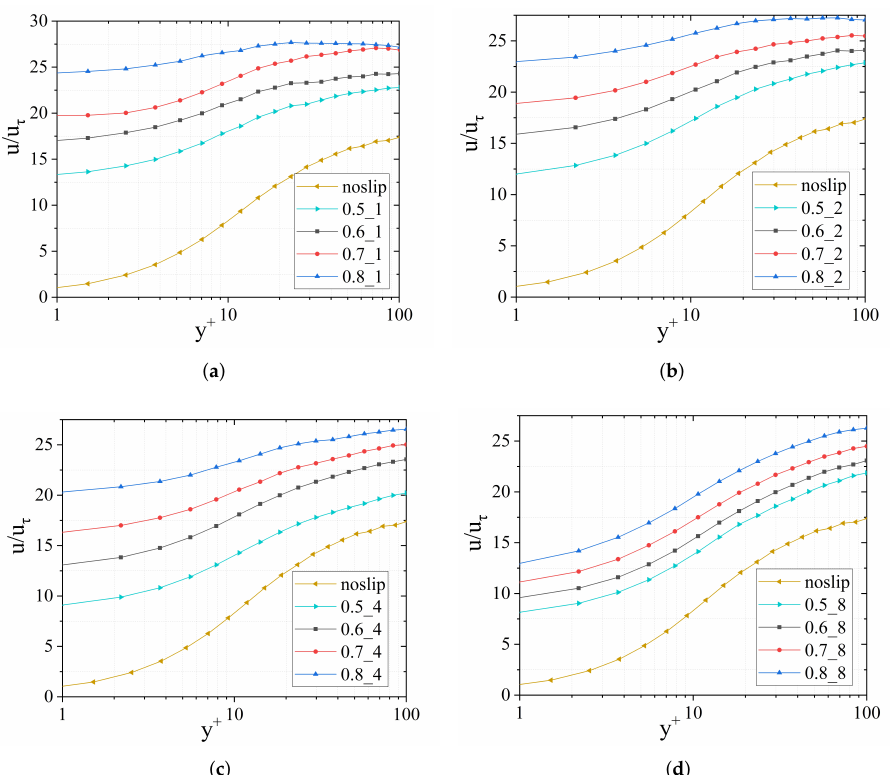
Figure 16. Comparison of mean velocity for same strips number at different GF. ( a ) Strip number = 1, GF = 0.5,0.6,0.7,0.8. ( b ) Strip number = 2, GF = 0.5,0.6,0.7,0.8. ( c ) Strip number = 4, GF = 0.5,0.6,0.7,0.8. ( d ) Strip number = 8, GF =